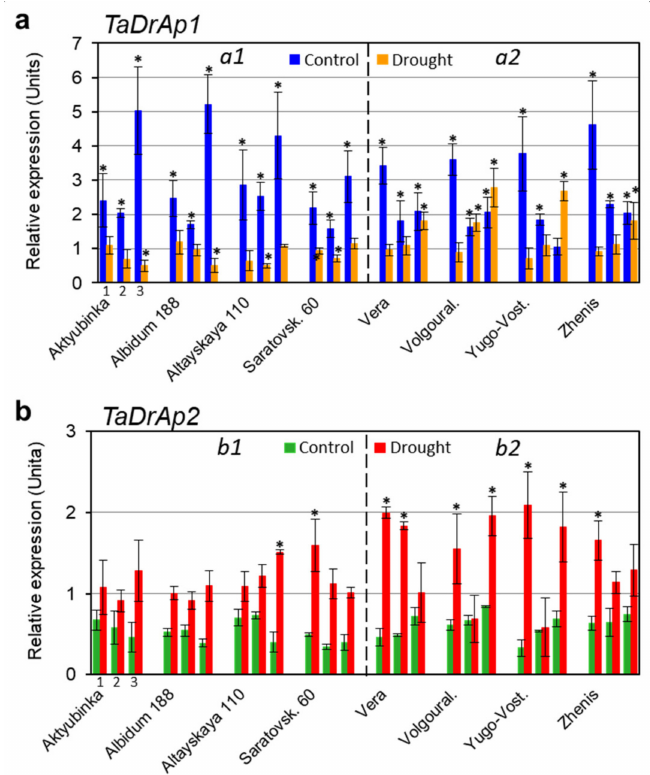
Figure 3. Expression analysis of TaDrAp1 ( a ) and TaDrAp2 ( b ) genes as a total of all homeologs for each gene across eight cultivars of bread wheat grown in Kazakhstan in control conditions and under moderate drought in pots with soil. Leaf samples were collected at three consecutive time-points for all genotypes as indicated by numbers for the first genotype: 1, vegetative stage, one month old; 2, tillering stage; 3, initiation of flowering stage. Wheat cultivars were arranged in two groups: high-yielding cultivars on the left part of the figure (Aktyubinka, Albidum 188, Altayskaya 110, and Saratovskaya 60) and low-yielding cultivars on the right (Vera, Volgouralskaya, Yugo-Vostochnaya, and Zhenis). Expression data were normalized using two reference genes, Ta22845 and Ta54825, and presented as the average ± SE of three biological and two technical replicates for each genotype and treatment. Di ff erences from relative level 1 are designated by asterisks above the bars, indicating significant di ff erences ( p < 0.05) for each genotype and treatment calculated using ANOVA. Expression level in all control samples of TaDrAp2 ( b ) was significantly below relative level 1, but not indicated by asterisks in the